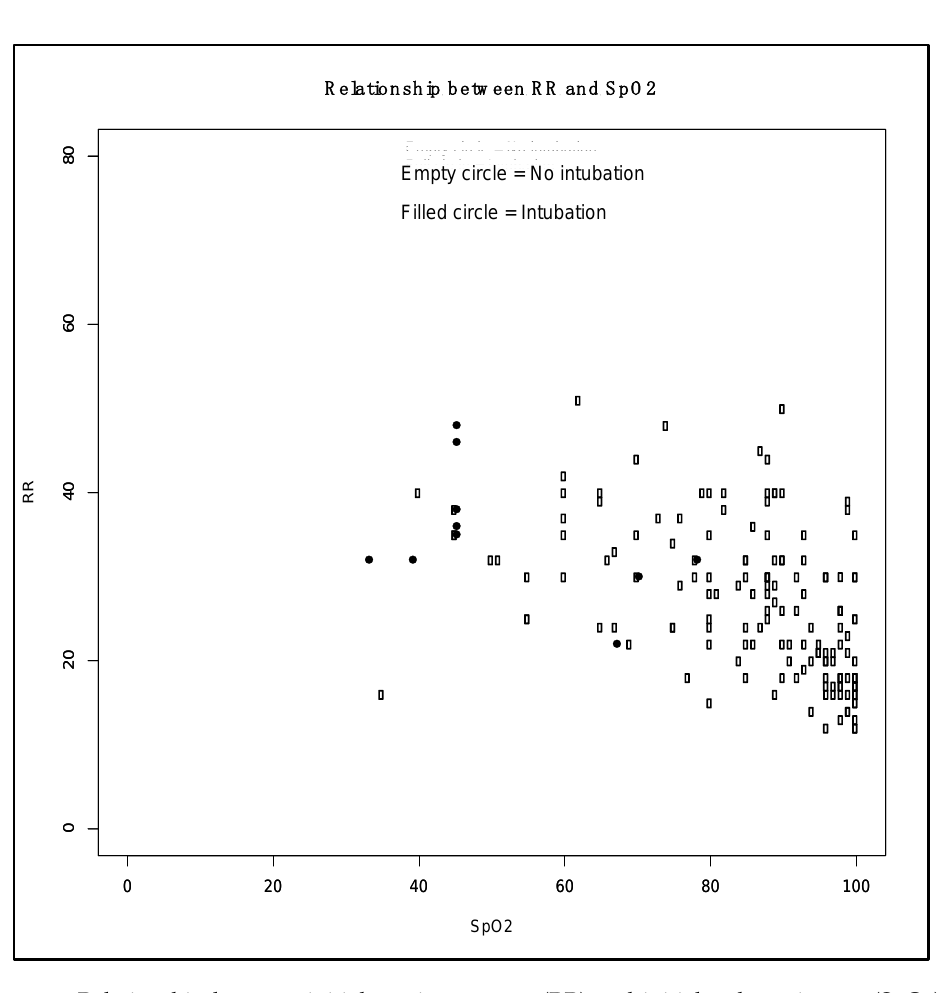
Figure 2. Relationship between initial respiratory rate (RR) and initial pulse oximetry (SpO 2 ) in intubated and non-intubated patients.